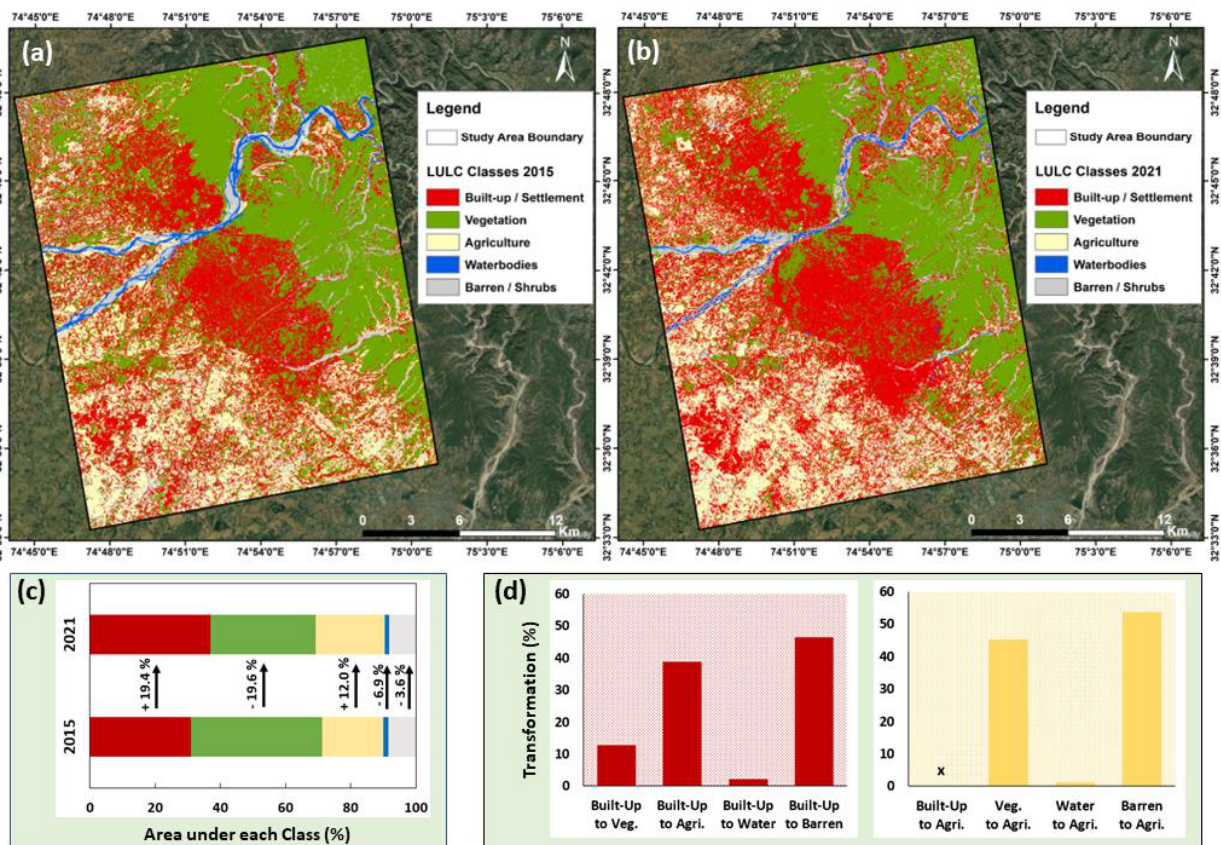
Figure 6. LULC Classification of the study area depicting fundamental classes relevant to this study for the years 2015 and 2021 based on Landsat-8 multispectral data. ( a ) LULC for 2015, ( b ) LULC for 2021, ( c ) Area under each LULC class during the study period and percentage change in each class from 2015 to 2021, ( d ) Percentage of different LULC classes to the total Built-Up and Agricultural lands (the classes which underwent an expansion and are considered contributors to land deformation) transformation.